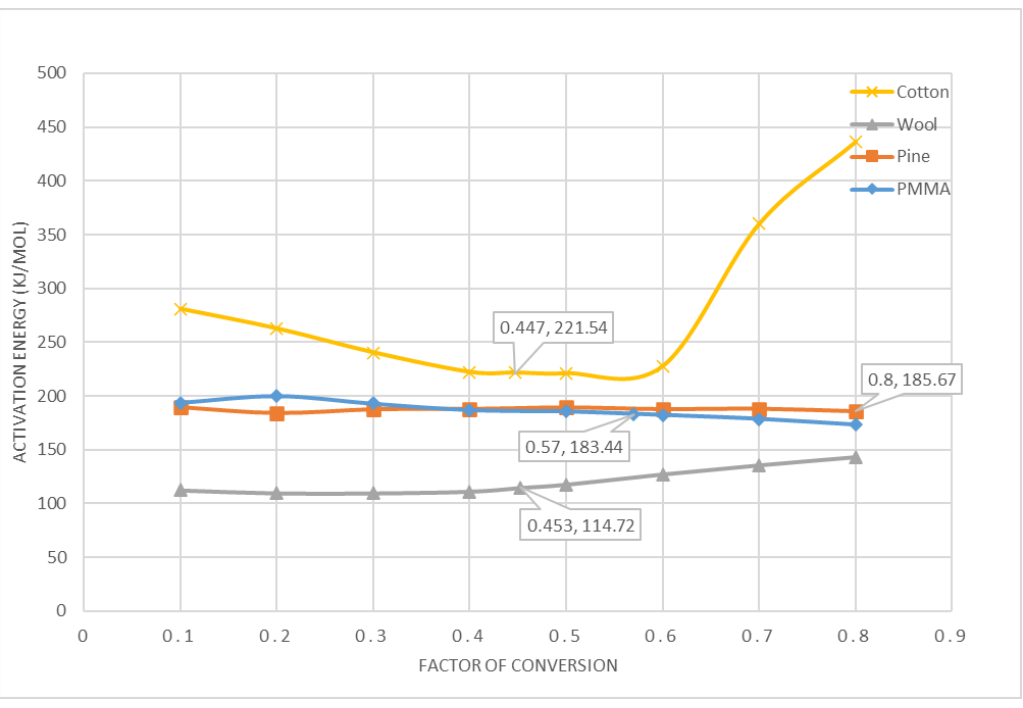
Figure 2. Variation of the activation energy for the materials using the OFW method.